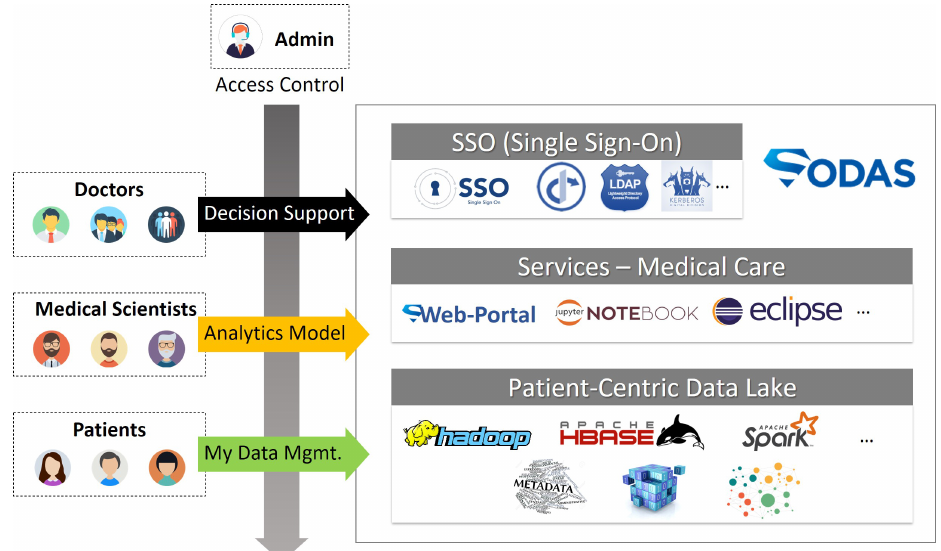
Figure 17. Working scenarios of PartnerHub